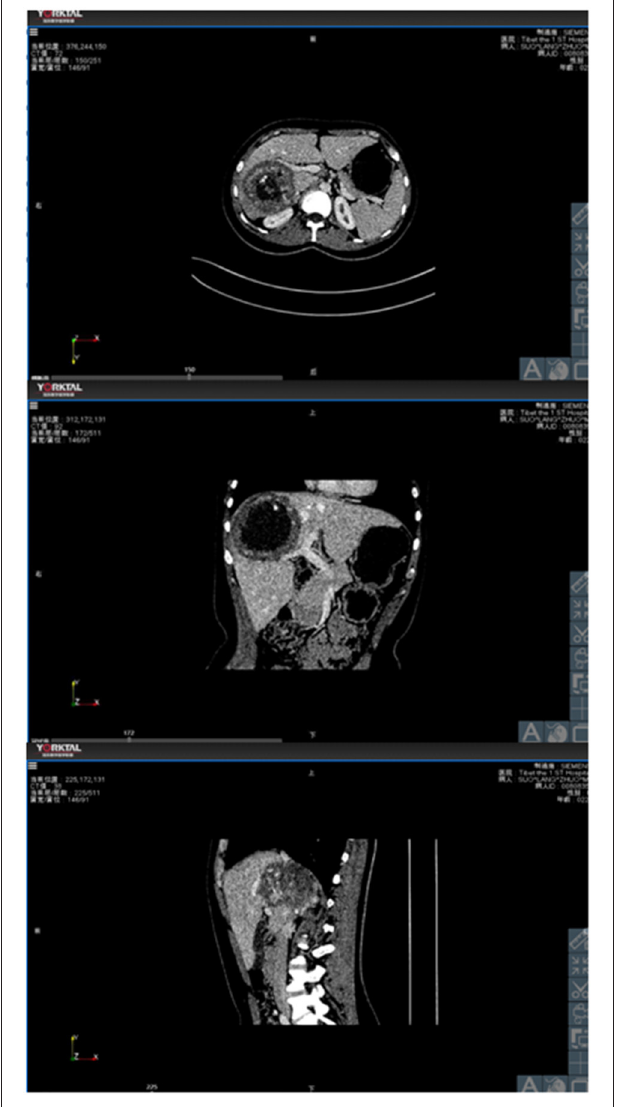
FIGURE 1 | The relationship between hydatid and portal vein, hepatic vein and inferior vena cava demonstrated by the cross-section, coronal and sagittal planes in